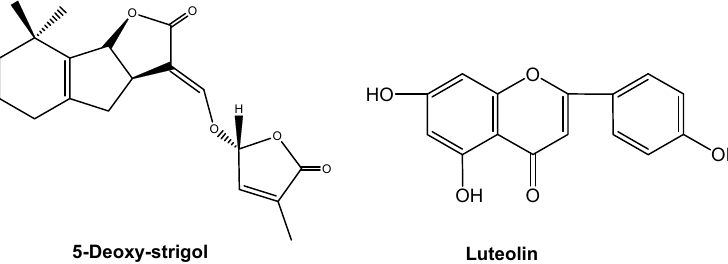
Figure 7. 5-Deoxy-strigol and luteolin involving in signaling interactions between plants and their symbiotic mycorrhizal fungi or rhizobia.